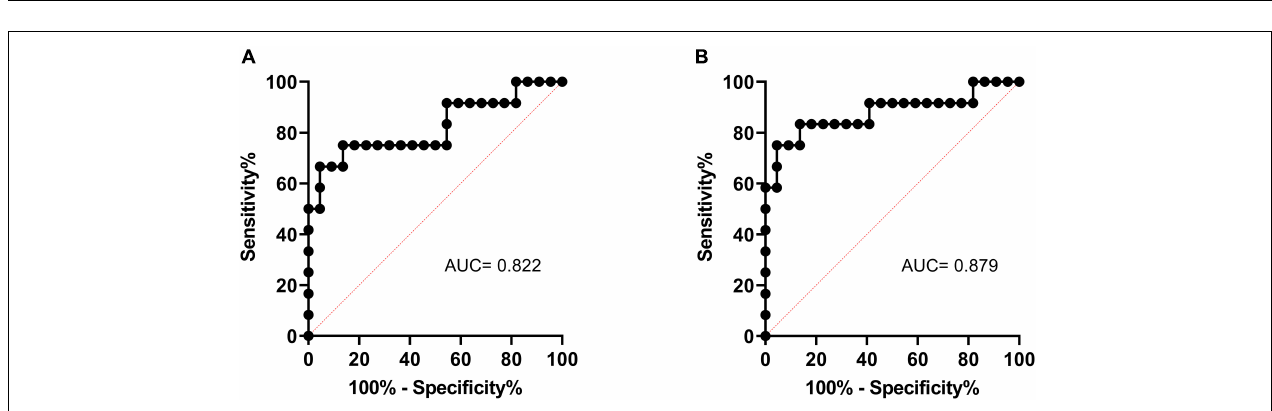
FIGURE 4 | The ROC curve of cortical R2* (A) and medullary R2* (B) in predicting SRF improvement. ROC, receiver operating characteristic; SRF, split renal function.